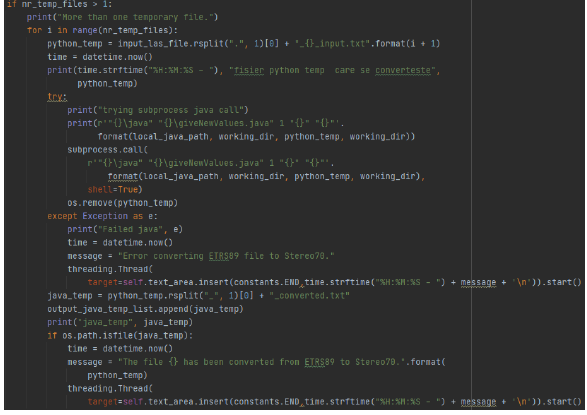
Figure 3 . Python code for the transformation from ETRS89 to Stereographic 1970, Back Sea 1975